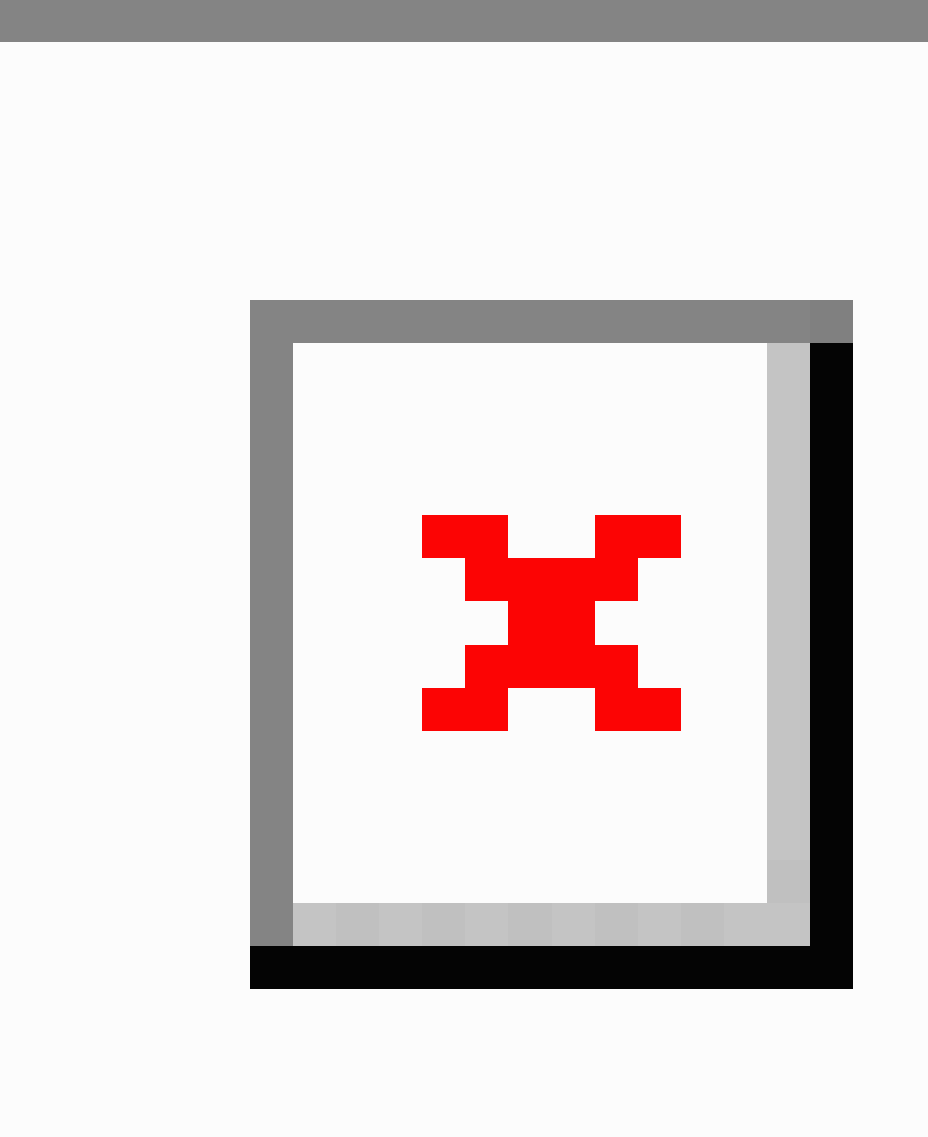
Figure 6. Equation for imbalance in the distributions of prognostic factors for two-way minimization